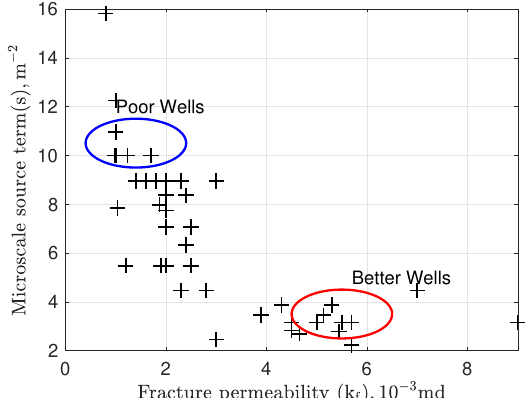
Figure 7. The microscale source term, s , represents microscale connectivity and the fracture permeability, k f , represents macroscale connectivity for 45 Barnett wells. There is a tradeoff between the macroscale and microscale stimulation because of energy conservation. More energy spent on the macroscale stimulation leaves less energy available for the microscale stimulation. The result is higher values of k f and lower values of s , and vice versa. The extreme values in the red and blue ellipse represent two different types of fracture networks after hydrofracturing that result in two different types of production profiles.